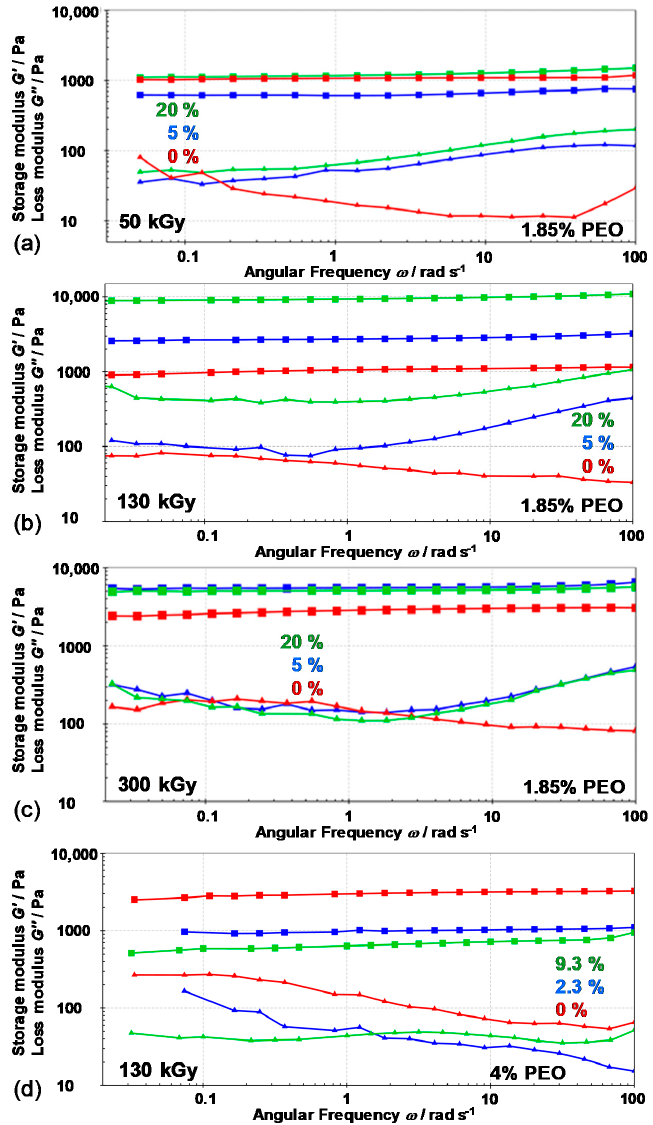
Figure 13. Frequency sweep tests ( G ′ ( ■ ) and G ″ ( ▲ ) values) of pure PEO gels and nanocomposite gels obtained at ( a ) 50 kGy, ( b ) 130 kGy, and ( c ) 300 kGy from 1.85 wt% PEO suspensions, and at ( d ) 130 kGy from 4.0 wt% PEO suspensions, at 25 °C. Initial mass percentage of Fe 3+ in precursor suspensions is indicated.